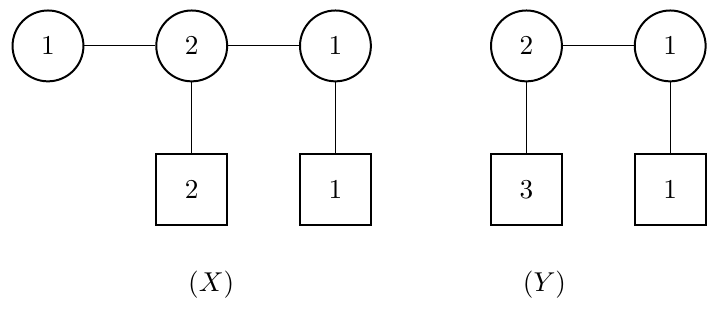
Figure 39 . A pair of linear quiver theories mirror dual to each